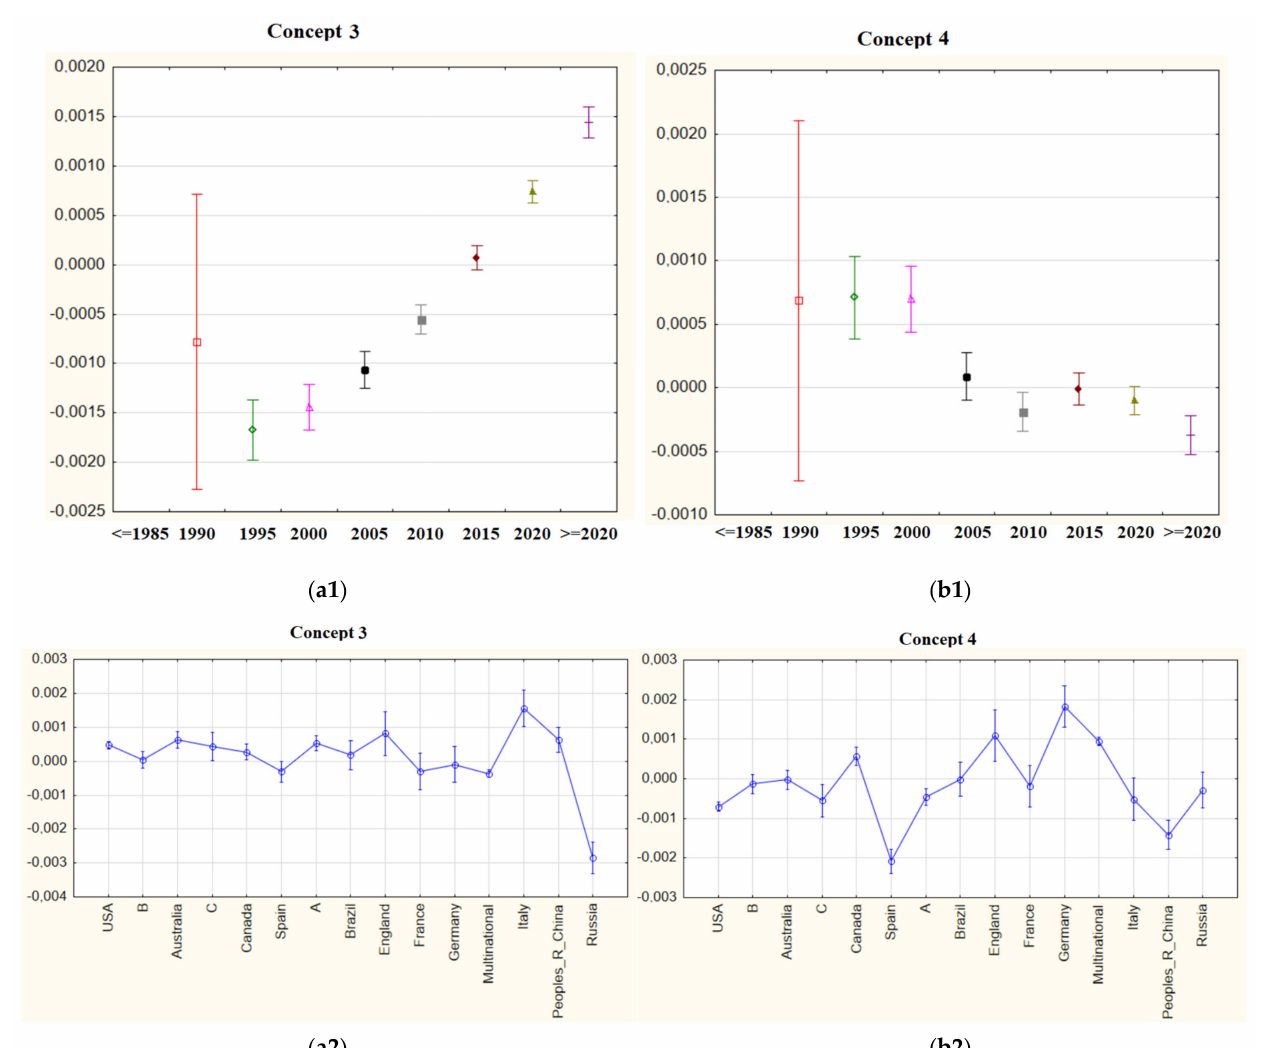
Figure 16. ( a1 ) mean importance weights of Concept 3 for five-year periods; ( b1 ) mean importance weights of Concept 4 for five-year periods; ( a2 ) mean importance weights of Concept 3 via countries; ( b2 ) mean importance weights of Concept 4 via